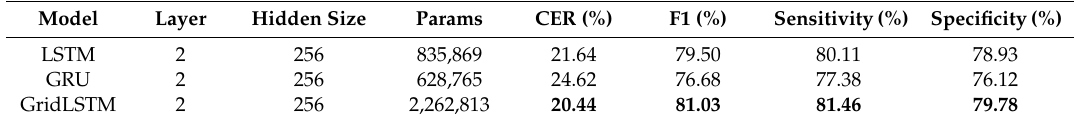
Table 1. Character error rate (CER) comparison of GridLSTM model and baseline. The bold data in table indicates the minimum CER and highest sensitivity, specificity, and F1 in the experiment.